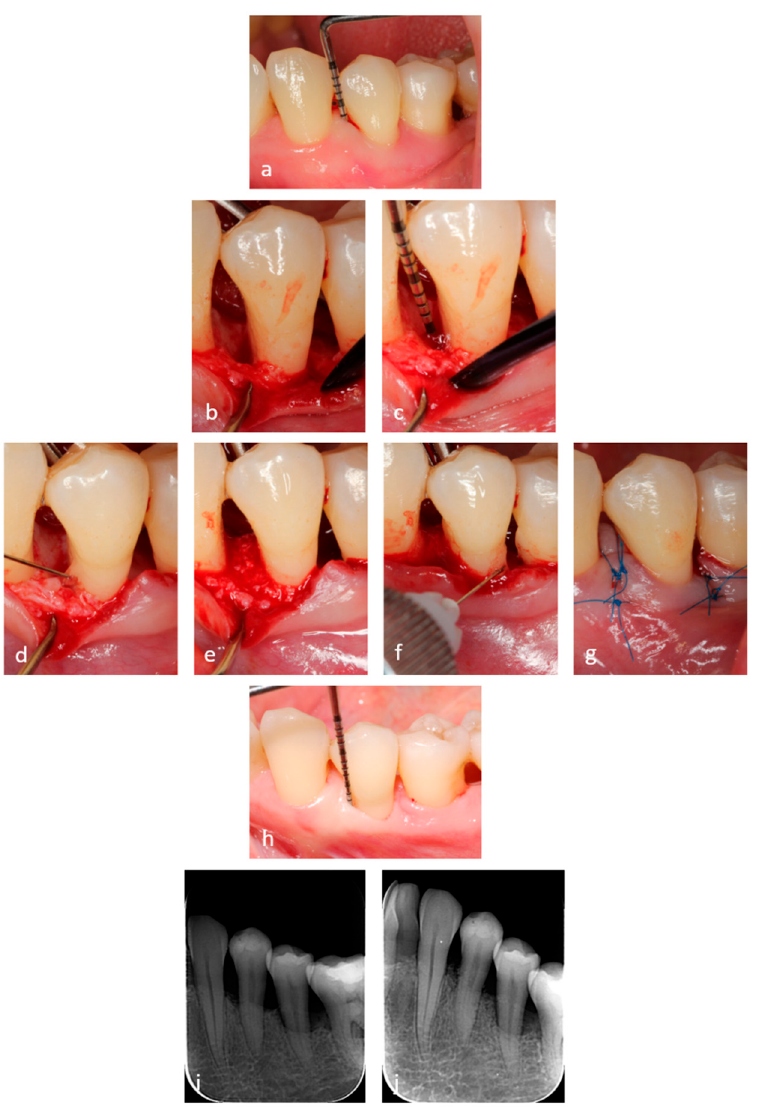
Figure 2. ( a ) Preoperative view and PPD depth of 8 mm. ( b , c ) Clinical intraoperative view of the defect with a 7mm depth of the intrabony component. ( d ) Clinical view of the instrumented root surface with a thin layer of HA applied. ( e ) Mixture of HA and xenograft gently packed in the in ‐ trabony defect. ( f ) HA layer applied before suturing on the surgical area. ( g ) Passive primary wound closure. ( h ) PPD of 2 mm at 6 months. ( i ) Pre ‐ operative radiographic finding. ( j ) Radiographic find